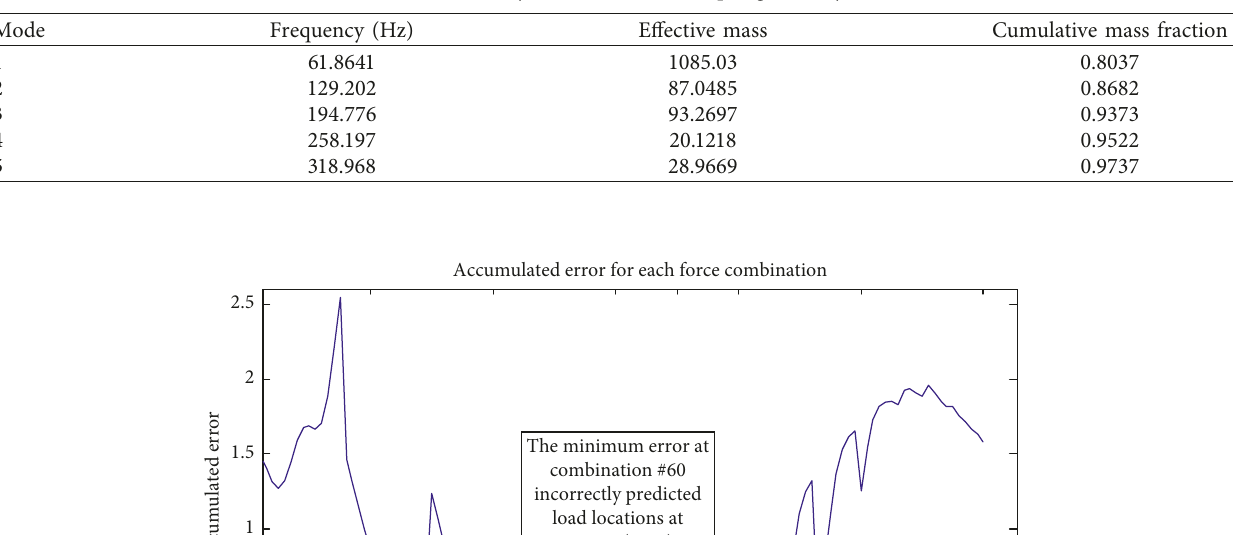
Table 1: Modal analysis for the 15-DOF spring-mass system.